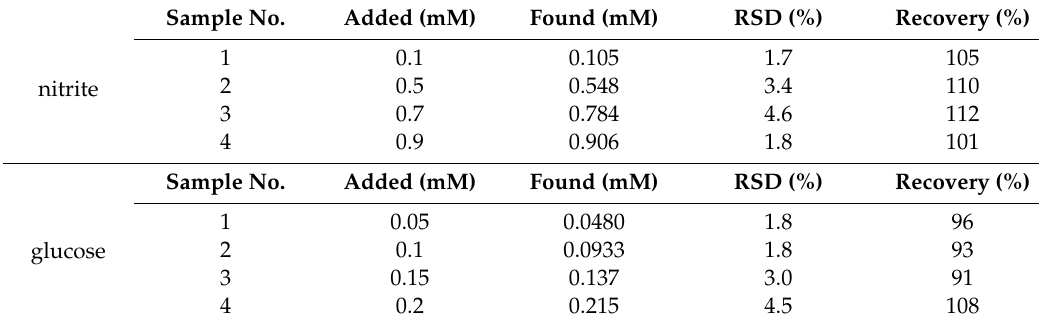
Table 5. Recovery test in artificial urine